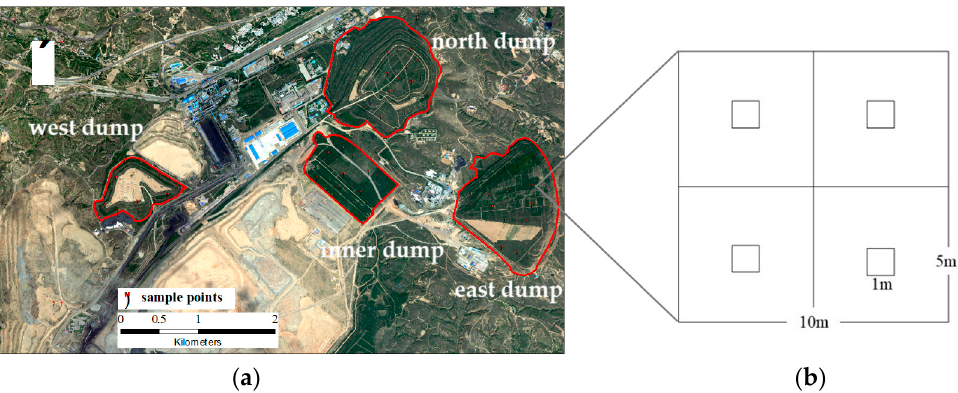
Figure 2. ( a ) Worldview-2 image showing the location of sampling points in Heidaigou open-pit coal mine; and ( b ) illustration of plot sampling strategy at each point.